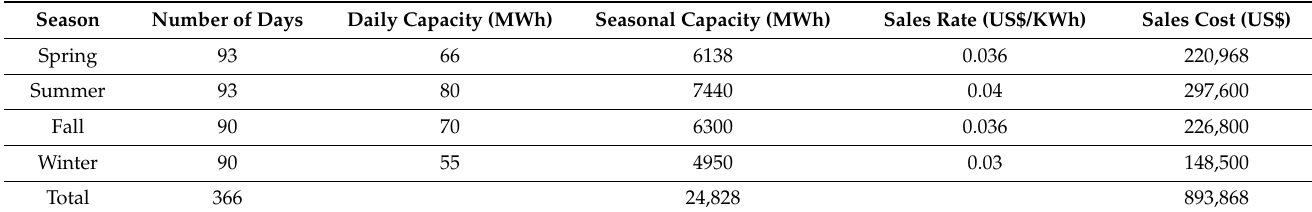
Table 7. Sales cost of a 10 MW solar power